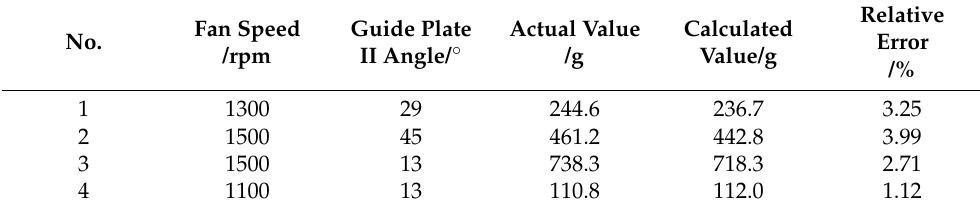
Table 5. Relative error between theoretical and practical values for Equation (1)